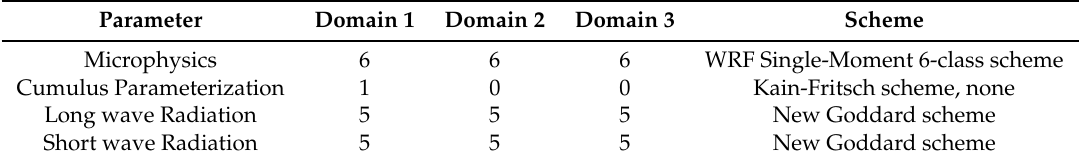
Table 2. WRF physics